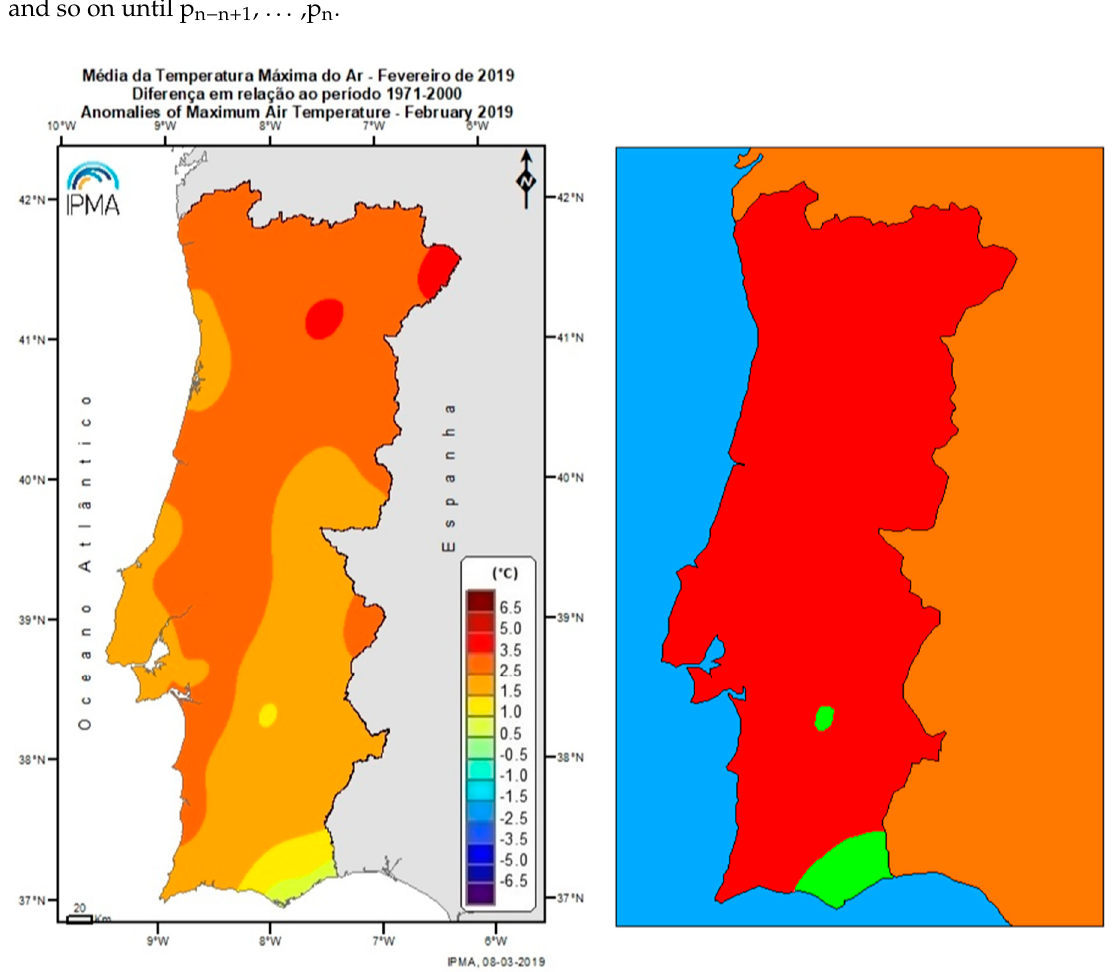
Figure 2. Example of the creation of isolines maps for the anomalies of in February in the year 2019. In the left part is the image obtained at the Portuguese Institute of the Sea and the Atmosphere (IPMA) website and in the right side is the image created from the first one.